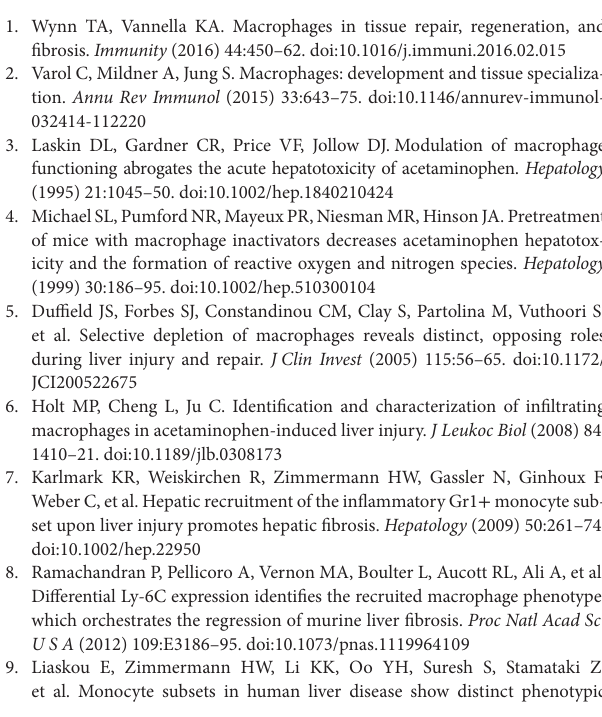
Figueiredo JL, et al. The healing myocardium sequentially mobilizes